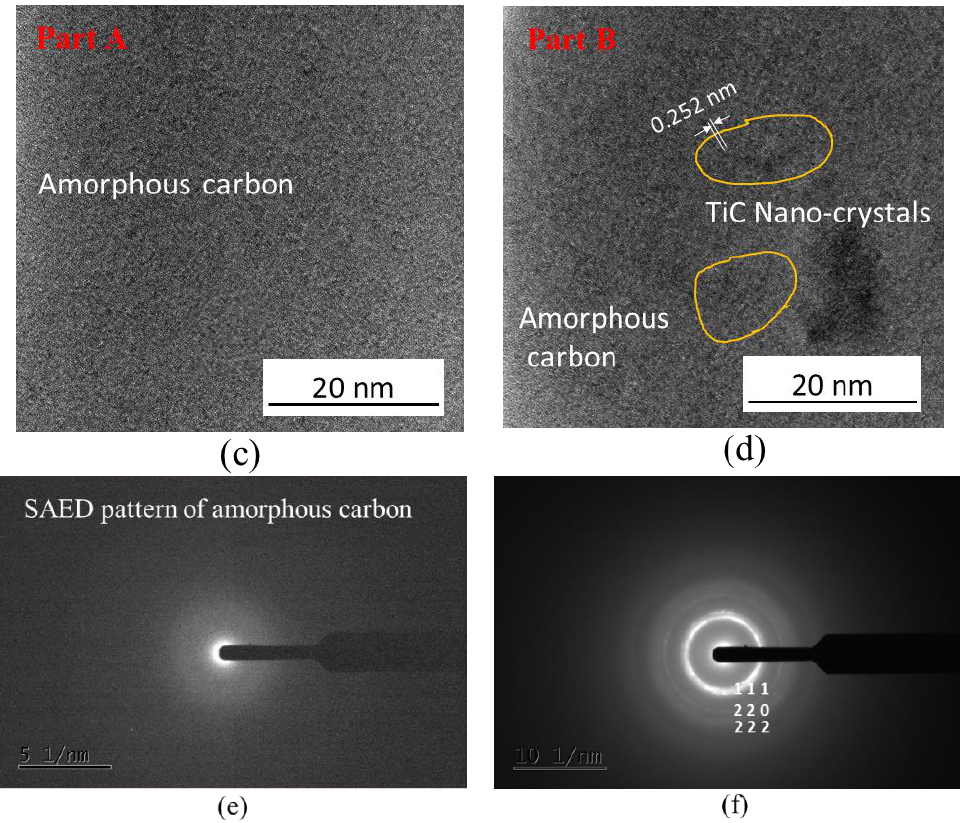
Figure 8. Schematic diagram ( a ) and TEM micrograph ( b ) of the DLC film deposited on titanium at CH 4 /H 2 = 1:0, 12 h; the selected area is marked with red square: TEM images and SAED patterns of ( c ) and ( e ) part A; ( d ) and ( f ) part B.